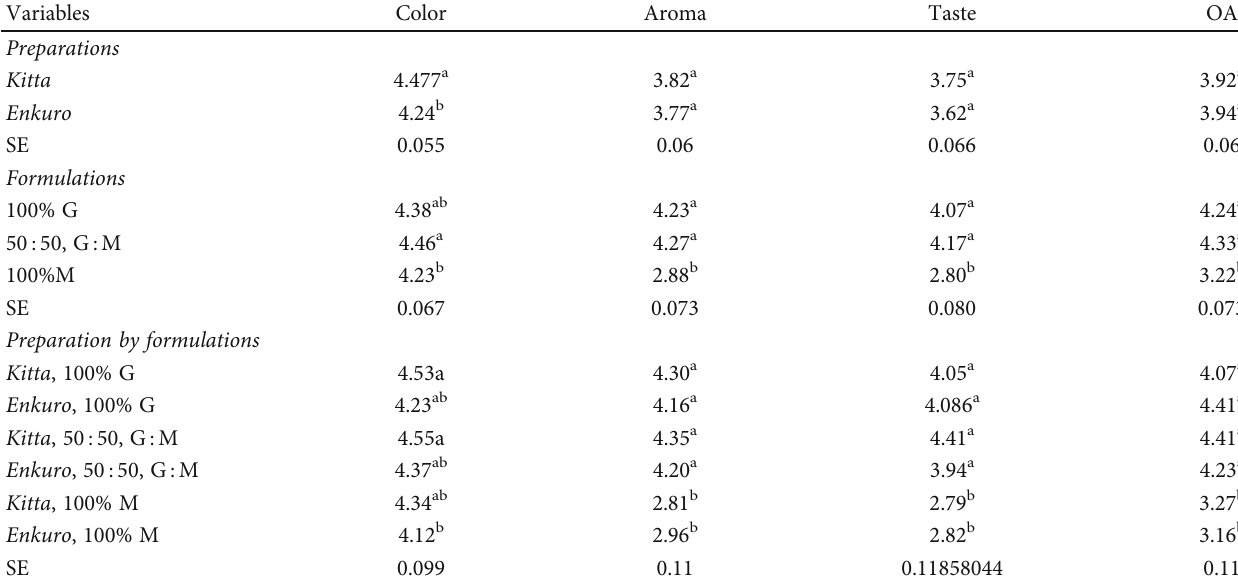
Table 4: Sensory acceptability of tella from the di ff erent preparations and formulations.